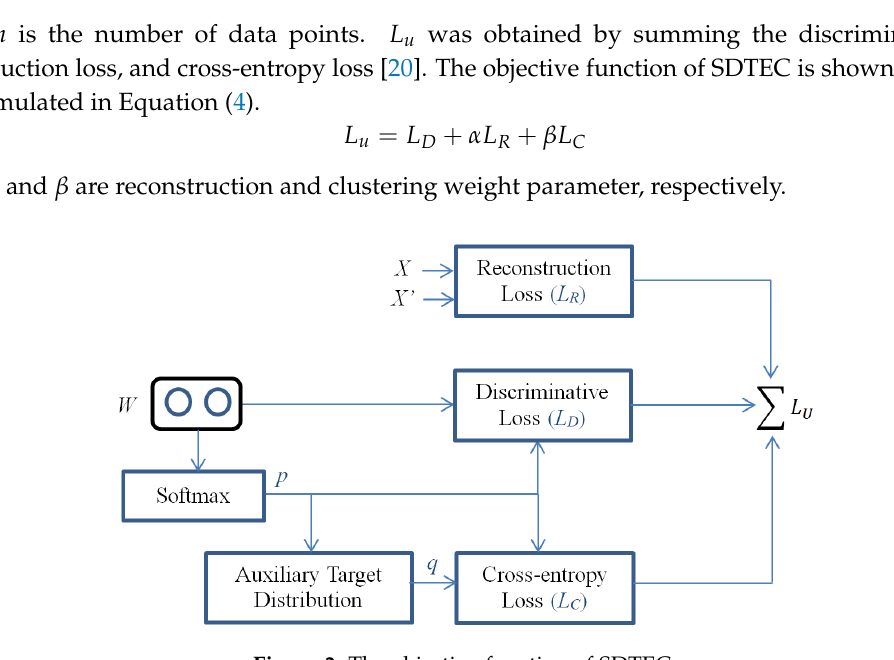
Figure 3. The objective function of